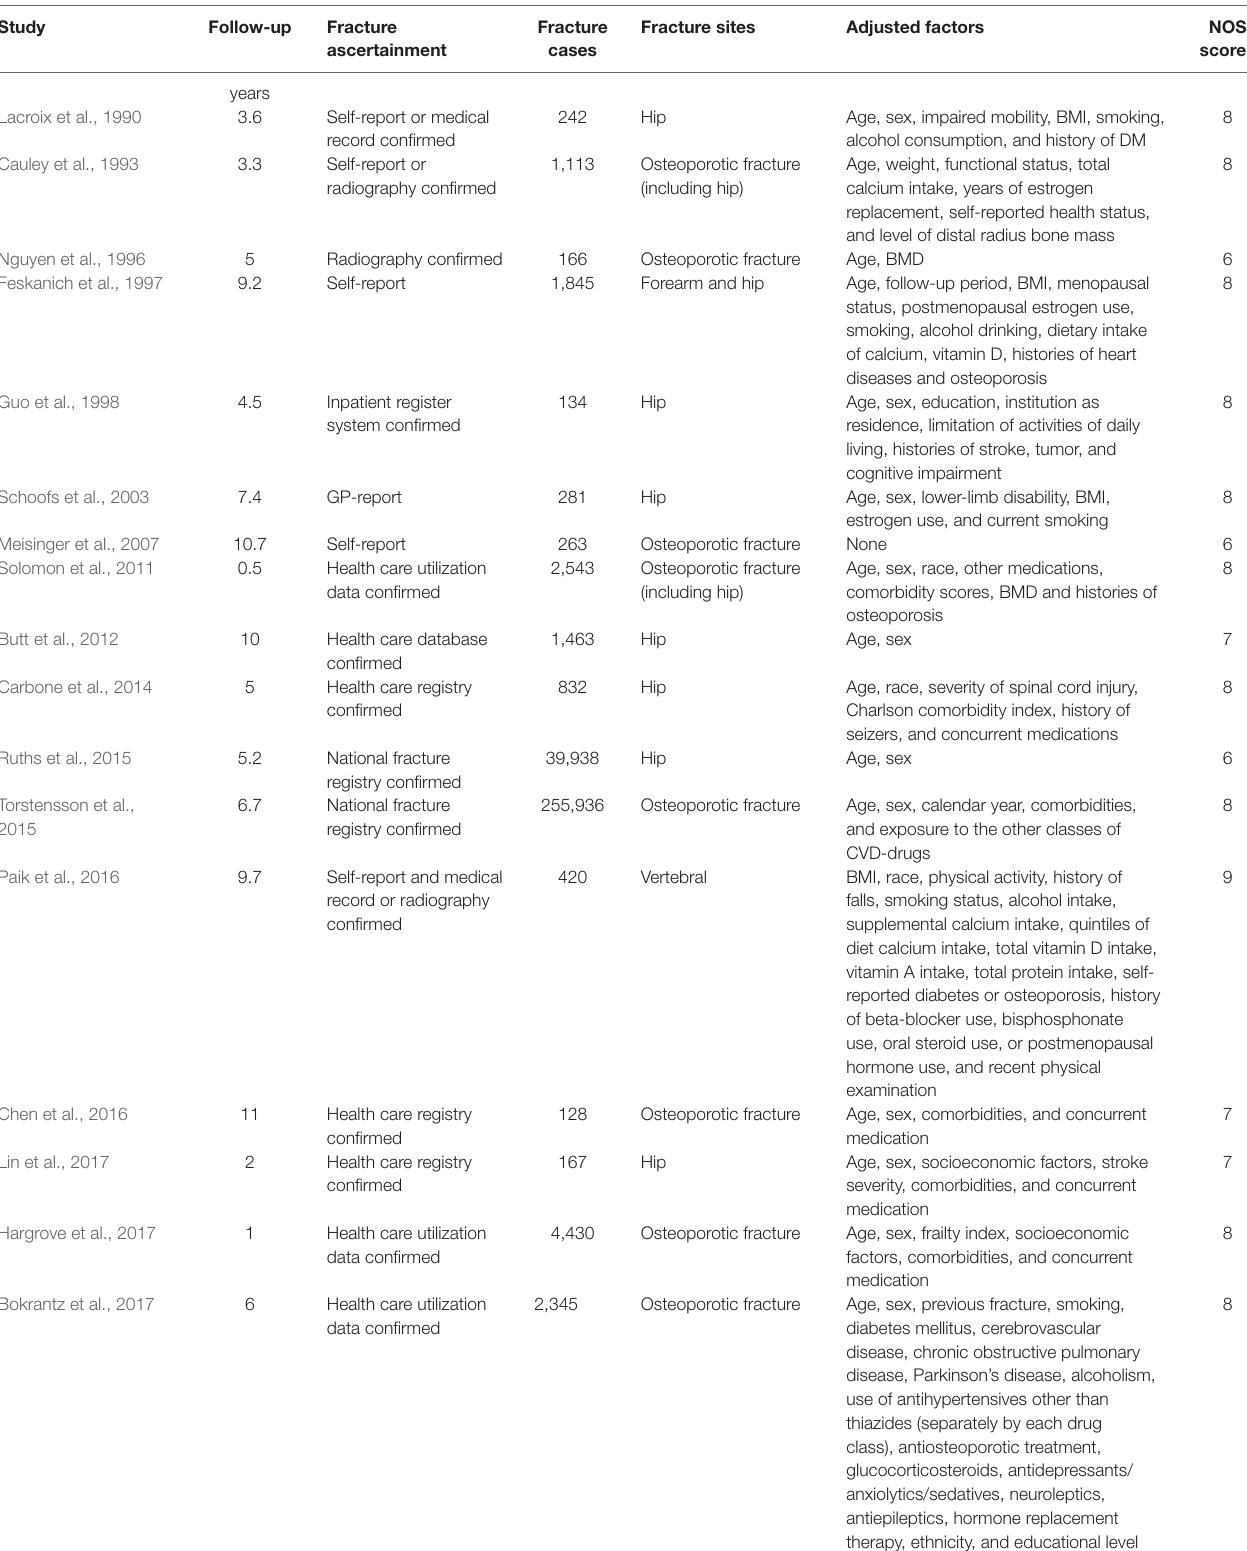
TABLe 2 | Characteristics of follow-up and outcome of the included